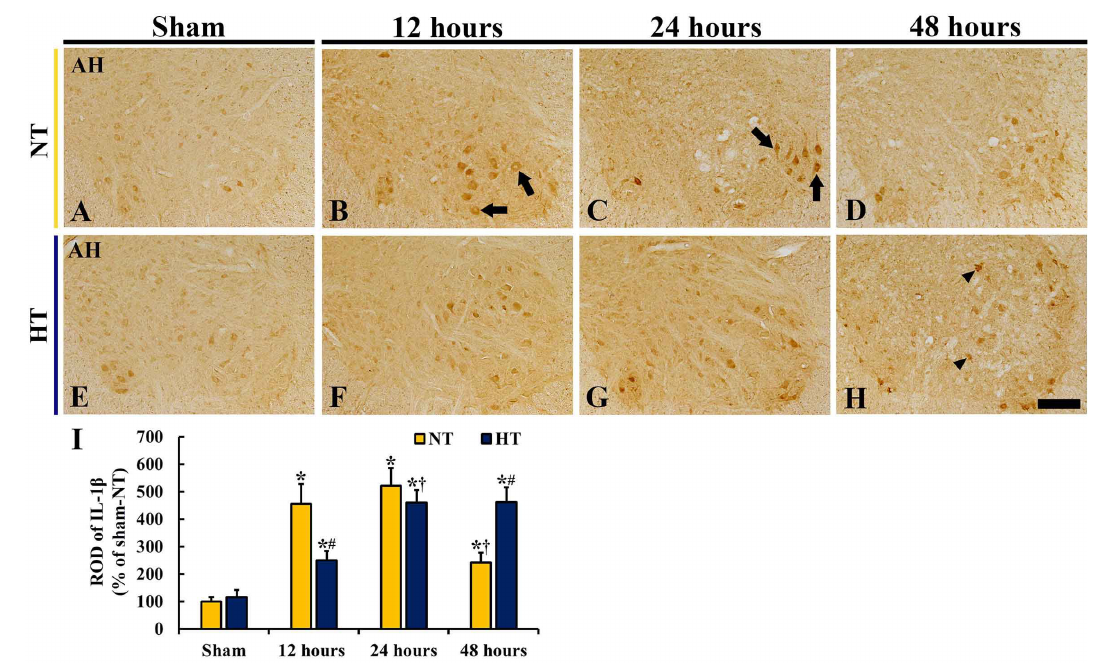
Figure 8. ( A – H ) IL- 1β immunohistochemistry in the anterior horn of the sham-NT ( A ), CA-NT ( B – D ), sham-HT ( E ), and CA-HT ( F – H ) groups at 12 ( B , F ), 24 ( C , G ), and 48 ( D , H ) hours after CA/ROSC. IL- 1β immunoreactivity is found in motor neurons. In the CA-NT group, IL- 1β immunoreactivity is significantly increased (arrows) at 12 and 24 h after CA/ROSC and then reduced at 48 h after CA/ROSC. In the CA-HT group, increased IL- 1β immunoreactivity at 12 and 24 h after CA/ROSC is lower than in the CA-NT group, but increased IL-1 β immunoreactivity at 48 h (arrowheads) is ap- parently higher than in the CA-NT group. AH, anterior horn. Scale bar = 200 µm. (I) ROD of IL- 1β + structures. The bars indicate the means ± SD ( n = 6, respectively, * p < 0.05 vs. each sham group; † p < 0.05 vs. previous time-point group; # p < 0.05 vs. corresponding CA-NT group).